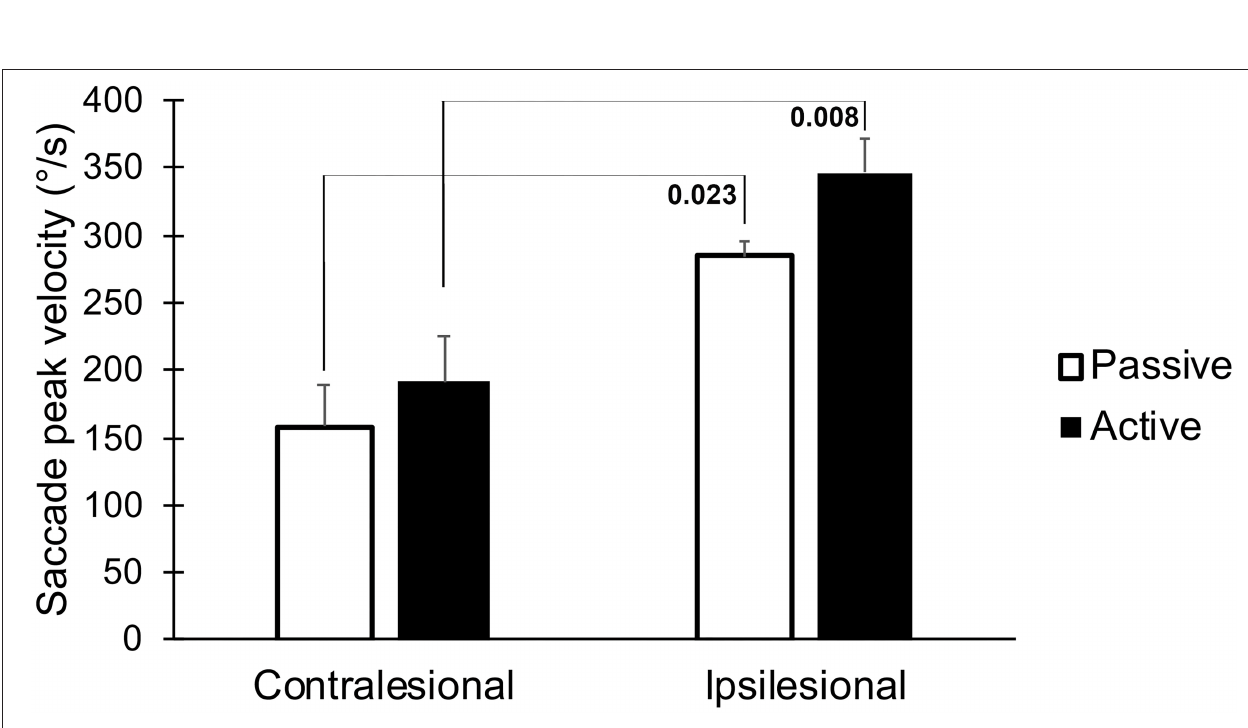
Frontiers in Neurology |